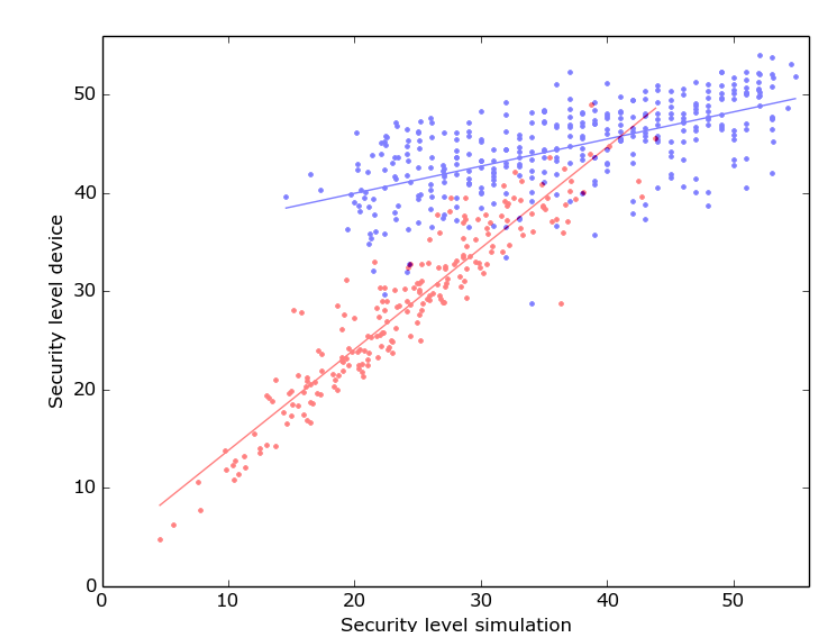
Figure 18: Two groups of random keys, one from a uniform distribution (blue) and one with skewed ratio of zeros and ones (red, either 90% zeros or 90% ones ). Security levels after attacking simulated and measured traces are shown on the x-axis and y-axis, respectively. Linear approximations are plotted for both